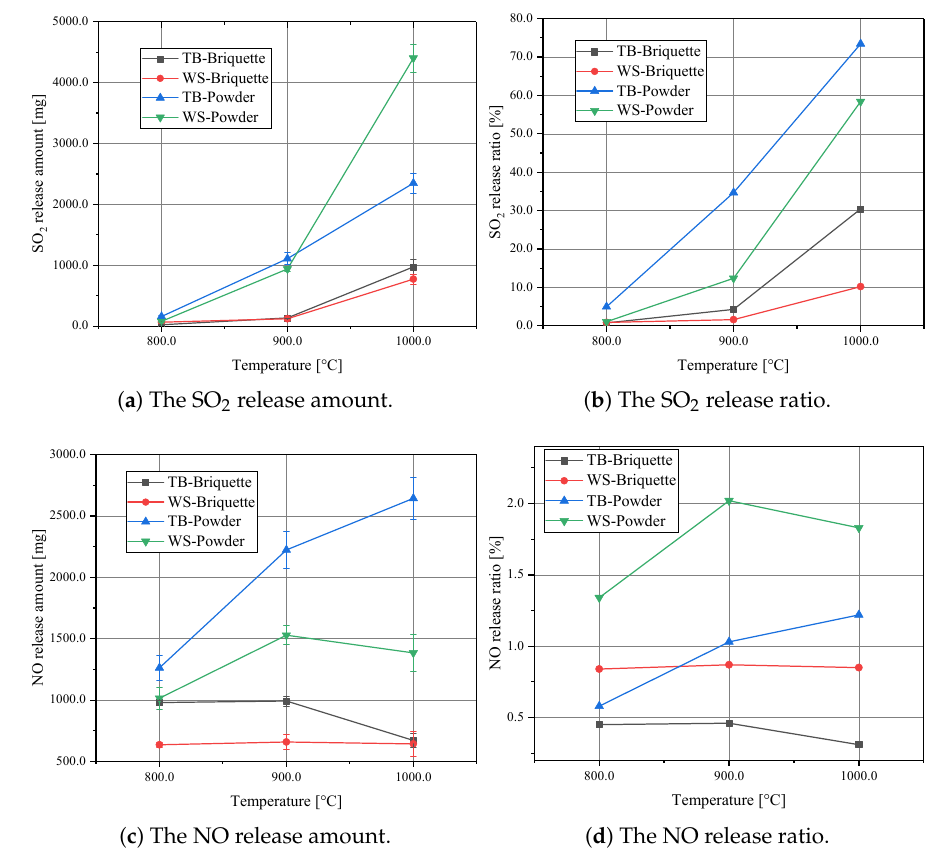
Figure 4. SO 2 and NO release curves for the biomass